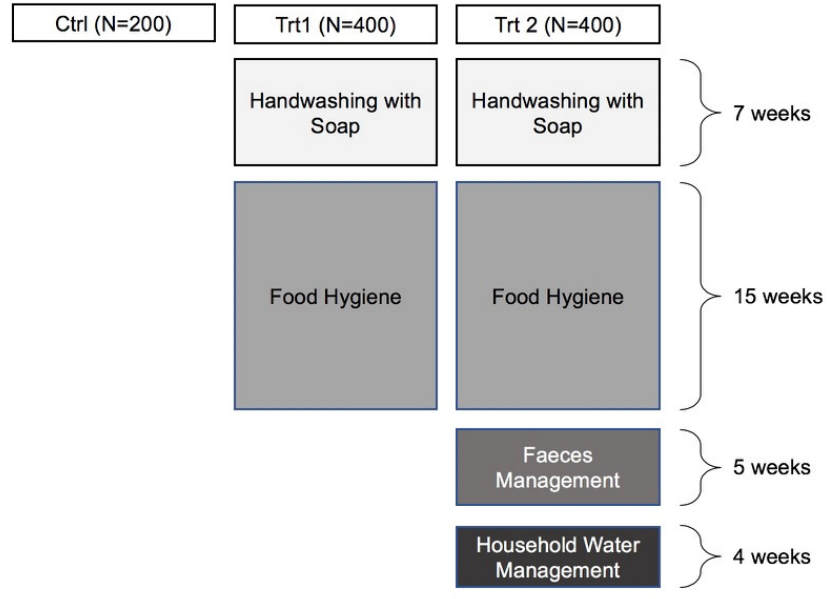
Figure 1. An outline of the intervention modules delivered within two treatment arms over the 31-week programme.